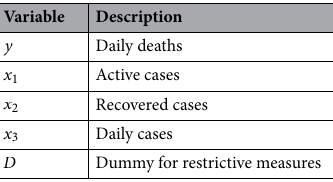
Table 4. Descriptions of variables for the daily deaths model.